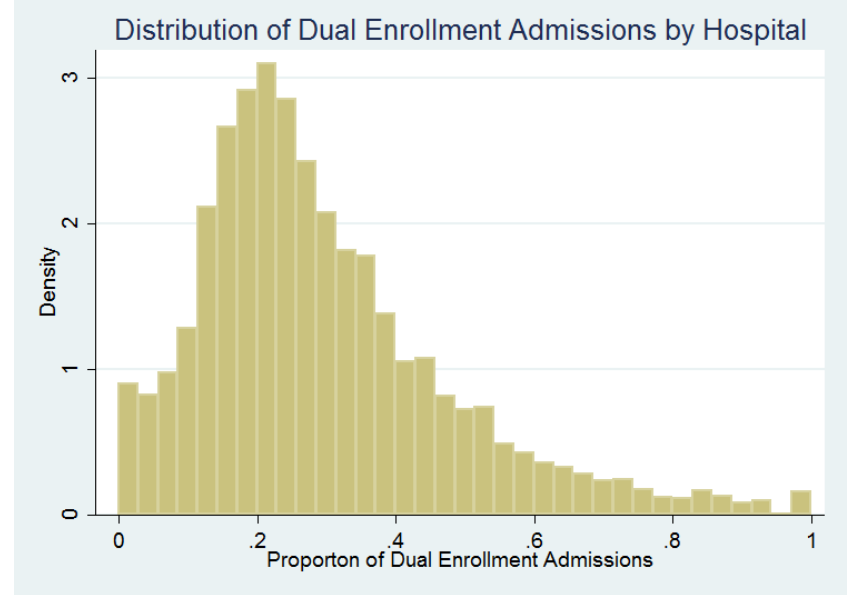
Figure 5.1. Distribution of Dually-Enrolled Admissions by